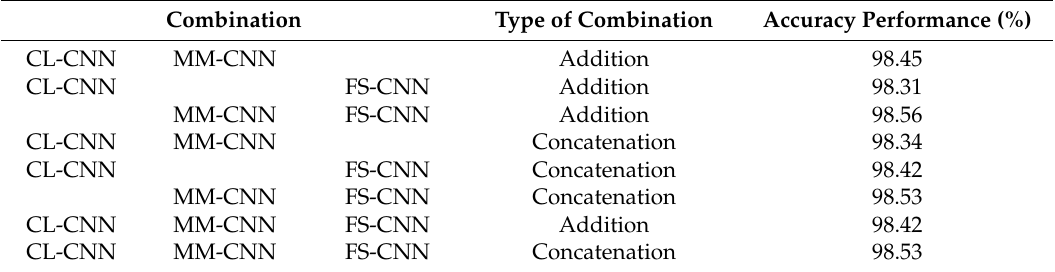
Table 6. Performance of Combining Features Generated by the last convolutional